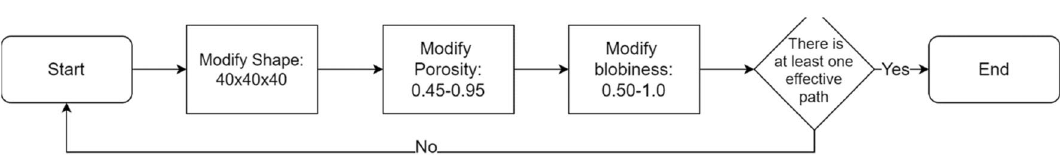
Figure 3. The flowchart shows the porous media generation steps considering the porosity and blobiness values 43